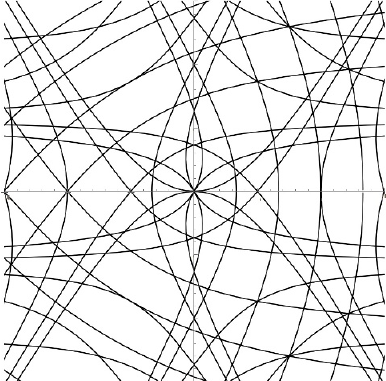
Figure 1. Truncation curves parametrized by ( L; M; N ) such that ( L +1)( M +1)( N +1) (cid:20) 6. This restriction means that the (cid:12)rst generator that we are quotienting appears at level (cid:20) 6 in the vacuum module. We use the parametrization from [10] where the two axes are related to (cid:21) i parameters by x = 1 (2 (cid:21) 1 (cid:0) (cid:21) 2 (cid:0) (cid:21) 3 ), y = 1 p ( (cid:21) 2 (cid:0) (cid:21) 3 ) which manifestly shows the S 3 triality symmetry. At 3 3